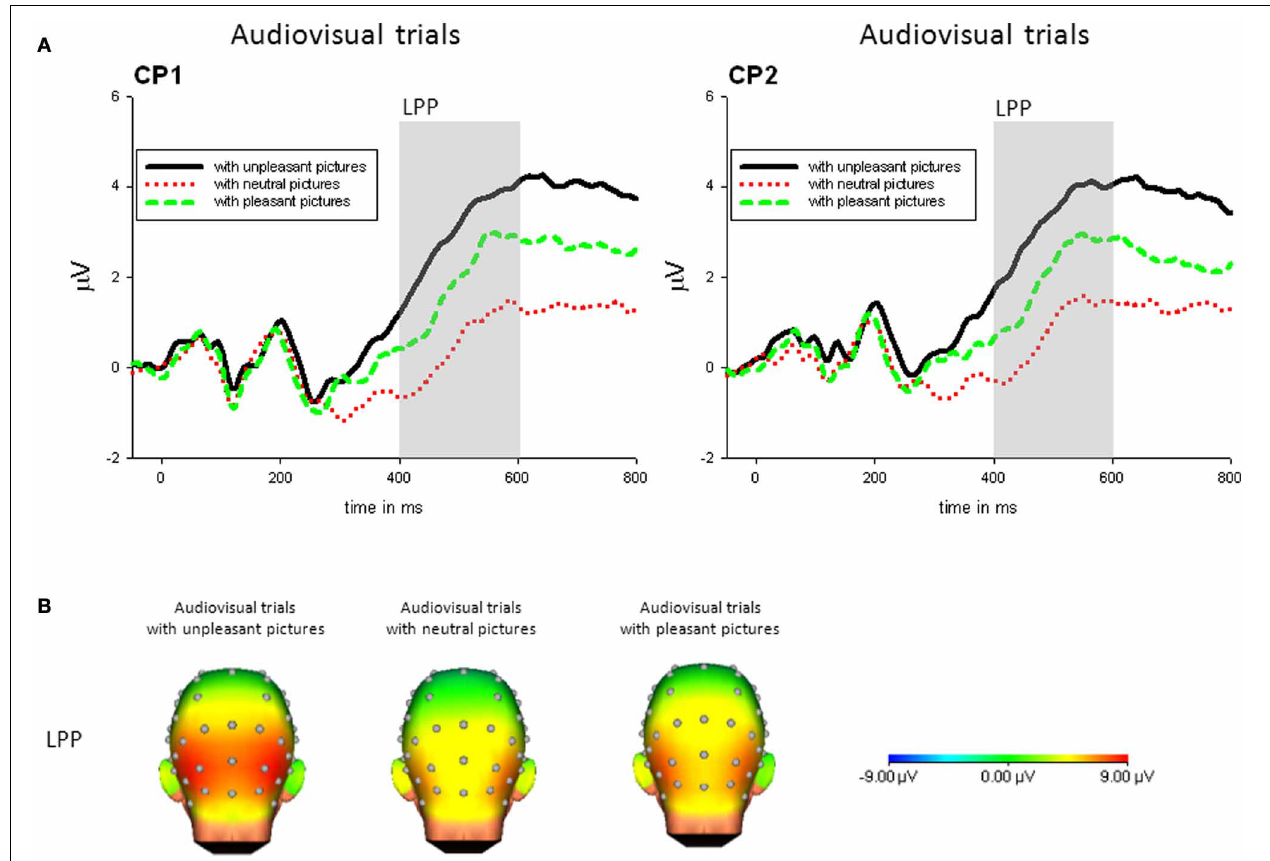
FIGURE 4 | (A) ERPs (in μ Volt) for representative channels (CP1, CP1) in response to audiovisual trials with pleasant, neutral and unpleasant pictures (collapsed across unpleasant, neutral, and unpleasant sounds). Gray boxes